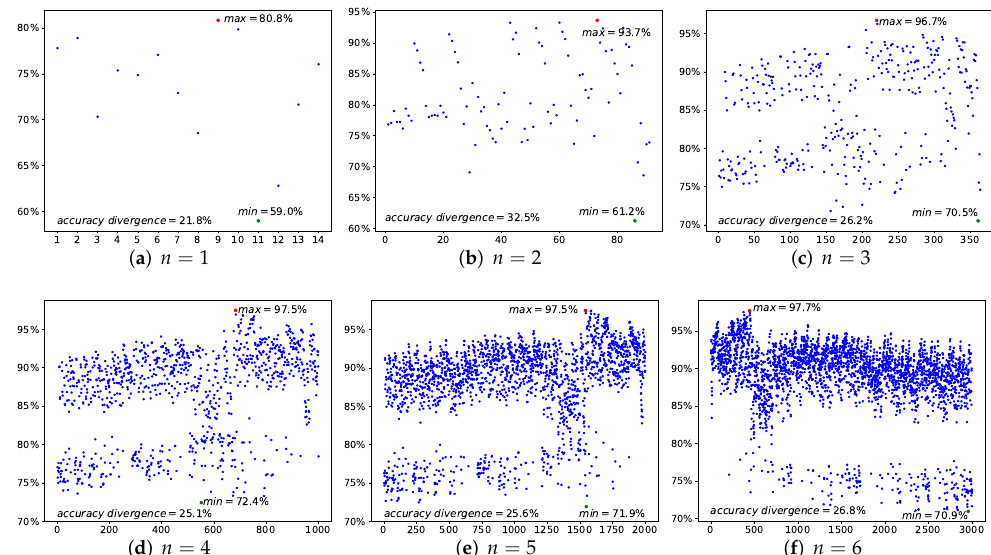
Figure 2. Extended Experiment. Subfigures ( a – f ) show all dominant corner combinations when the number of dominant corners varies from 1 to 6. n refers to the number of dominant corners, and each blue dot represents a dominant corner